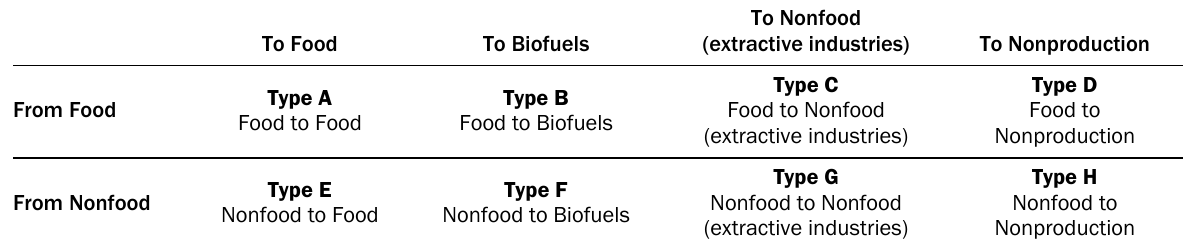
Figure 3. A New Typology of Land Use Change